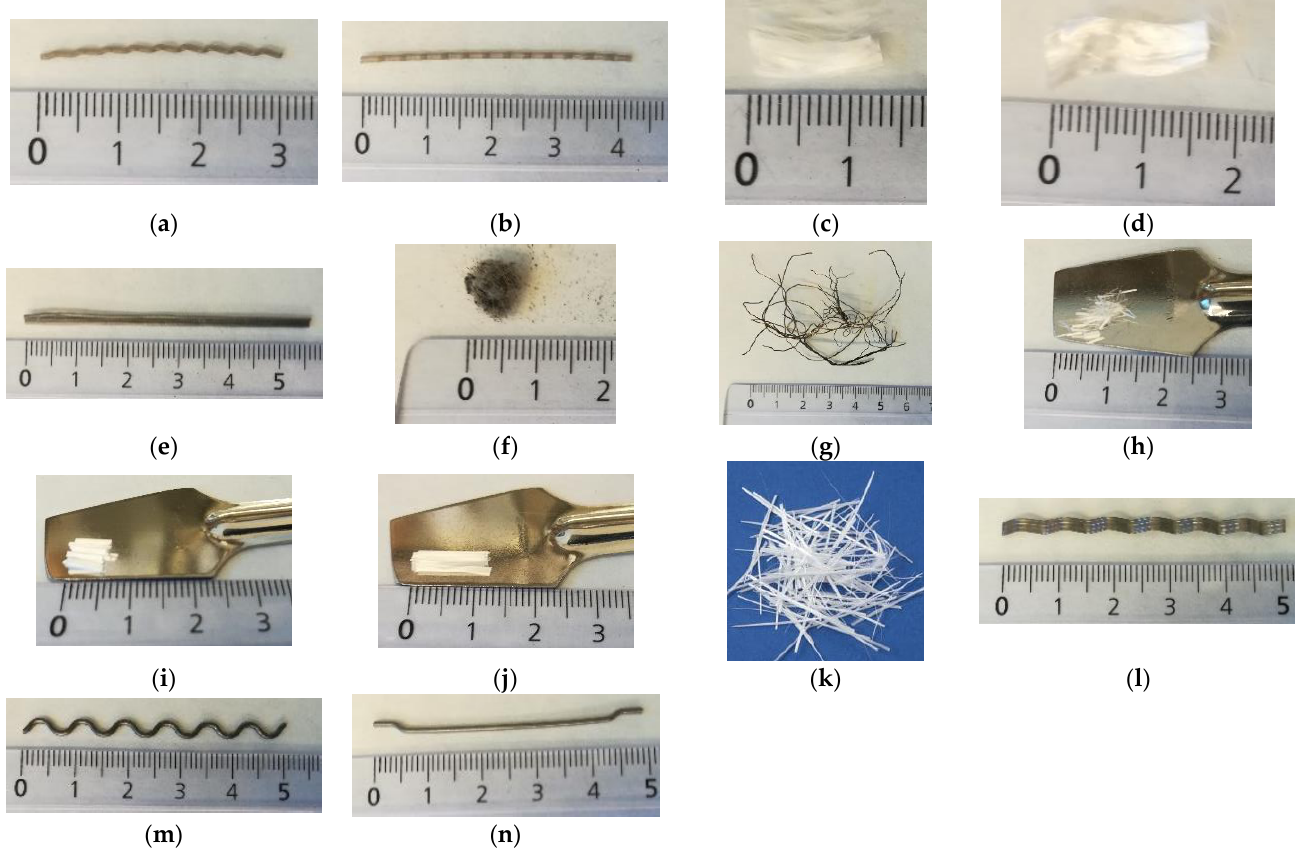
Figure 2. Fibers used in this research. Polypropylene fibers: ( a ) ST30, ( b ) ST42, ( c ) NS12, ( d ) NS18, ( e ) CN54. Pneumatic fibers: ( f ) TF-TR, ( g ) MF-TR. Glass fibers: ( h ) HD3 ( i ) HD6 ( j ) HD12 ( k ) HP. Metal fibers: ( l ) RW50+, ( m ) RW50, ( n ) MF-FP. Table 4. Characteristics of fibers considered in this study as given by the technical datasheet